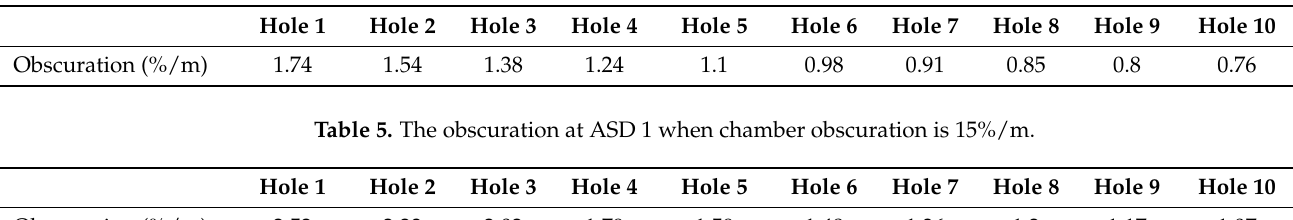
Table 3. The obscuration at ASD 1 when chamber obscuration is 5%/m.